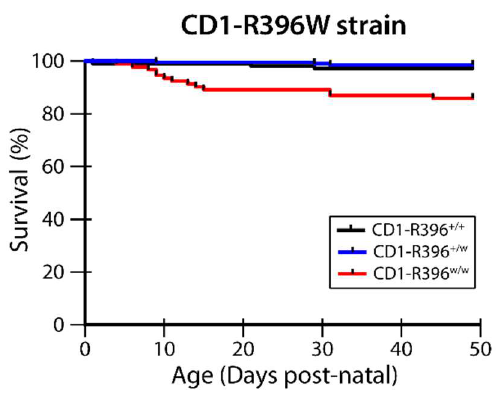
Figure 5. Survival of CD1-R396 w/w mutant pups. Cages were monitored daily until postnatal day 49 and cadavers found in cages were genotyped. Percent survival for all 3 genotypes is shown.